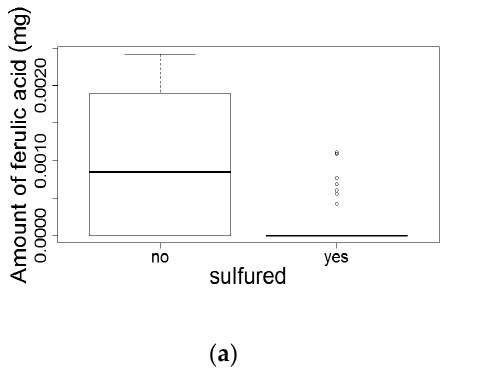
Figure 4. Comparison of ( a ) ferulic acid and ( b ) Z ‐ ligustilide levels between sulfured and unsulfured whole roots. Error bars represent the 95% confidential intervals (sulfured, n = 64; unsulfured, n = 24). Note: the HPTLC analysis for ferulic acid of sulfured roots yielded a majority of samples below the detection limit.